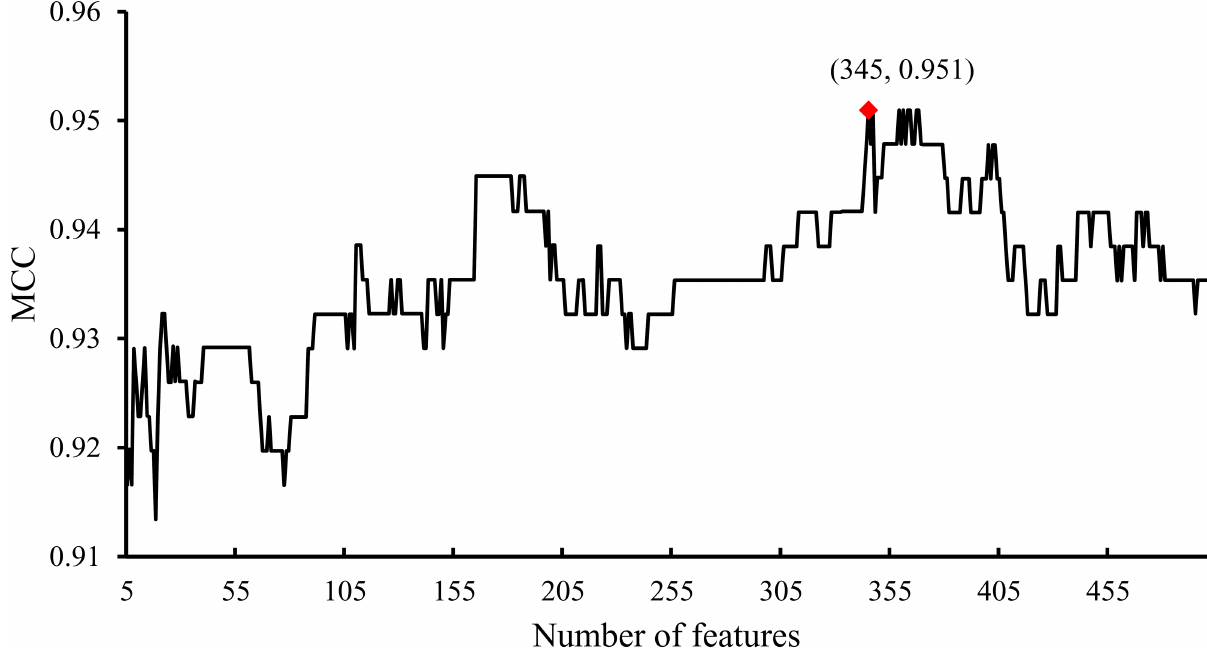
Fig 2. The IFS curve using the MCC as its Y-axis and the number of features participating in classification as its X-axis.